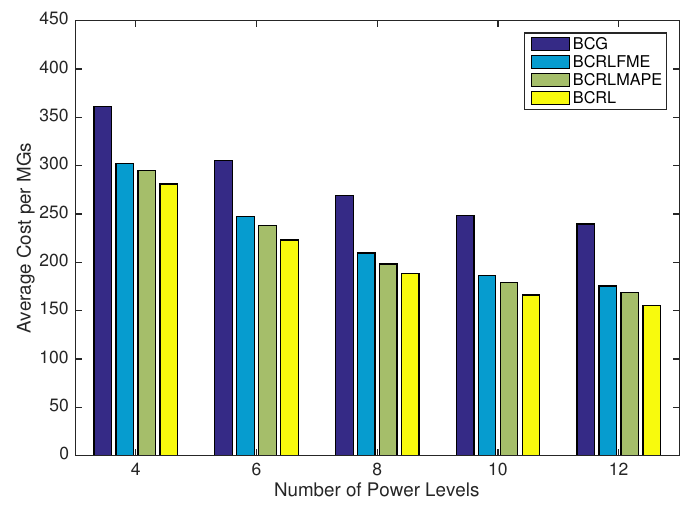
Figure 3. Average cost per microgrid versus the power